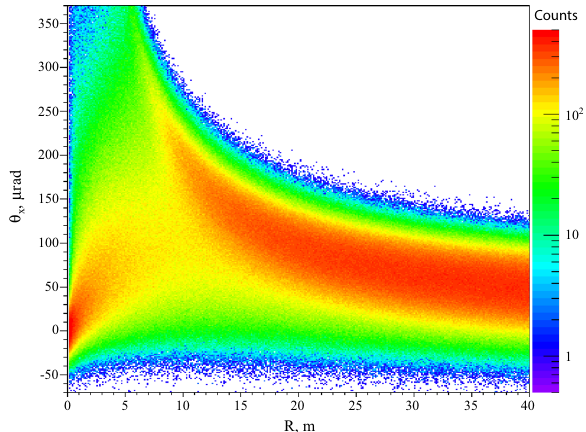
Fig. 4 The dependence of the number of electrons deflected on the angle θ x on the radius of curvature of the crystal for the (cid:2) 110 (cid:3) crystal orientation with respect to impinging particles